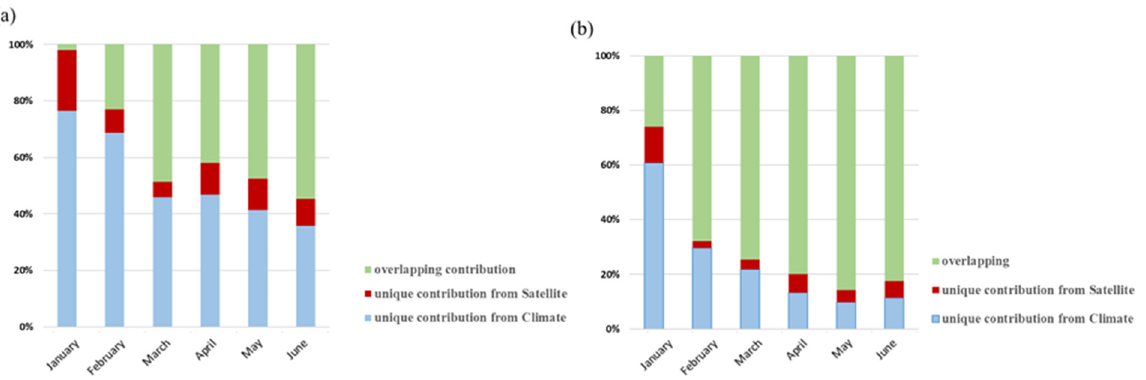
Figure 7. Independent and overlapping contributions of satellite and climate data to the model: ( a ) MLR, ( b ) RF.